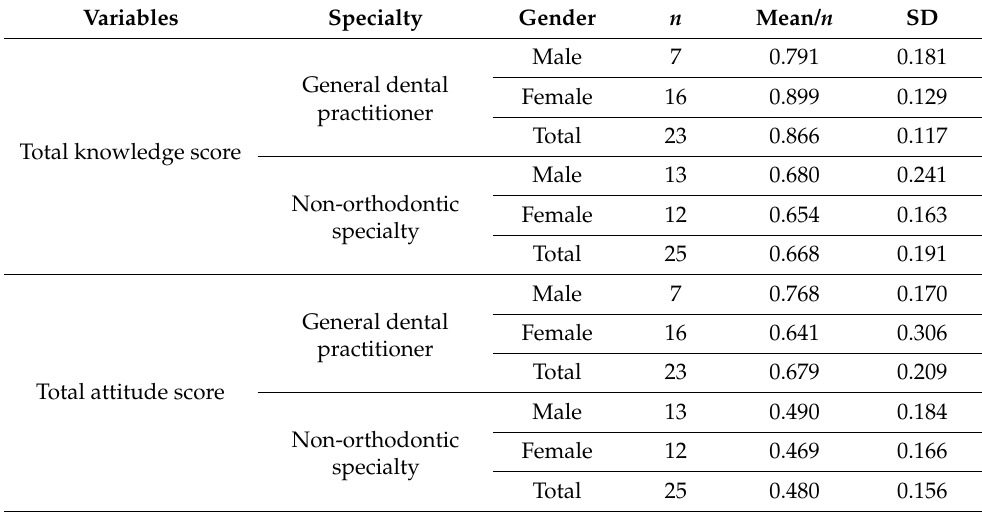
Table 4. Comparison of knowledge and attitudes between practitioner classification and gender ( n = 48).